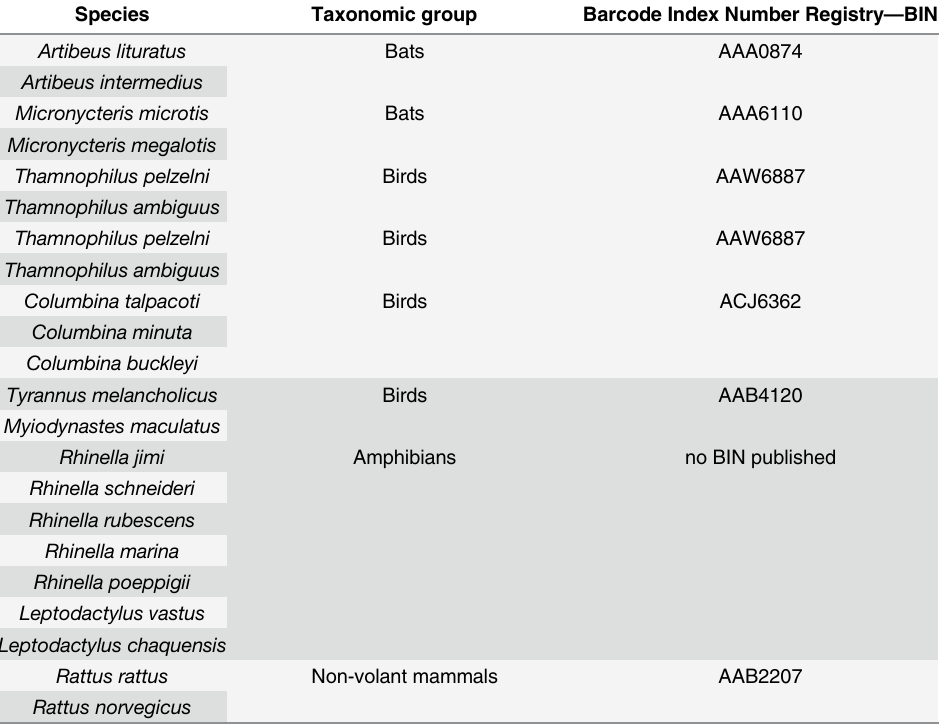
Table 4. Ambiguous species identification obtained after BOLD